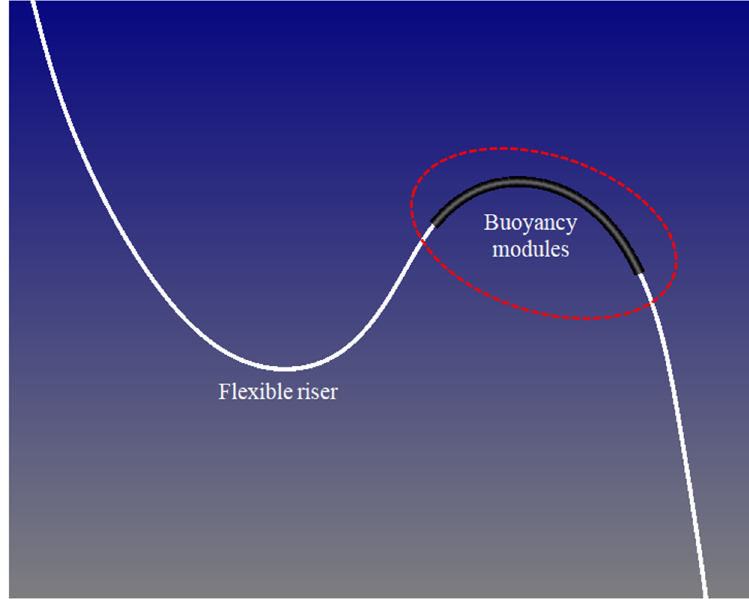
Figure 10. Buoyancy modules attached to riser system.